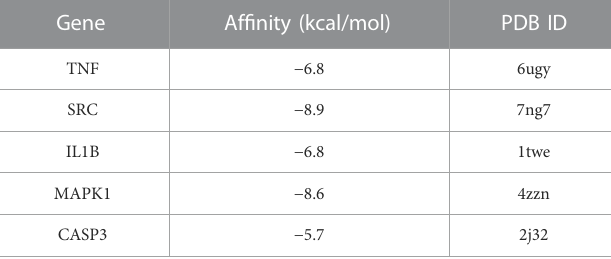
TABLE 4 The binding energy of NG-R1 and core targets (kcal/mol). Gene